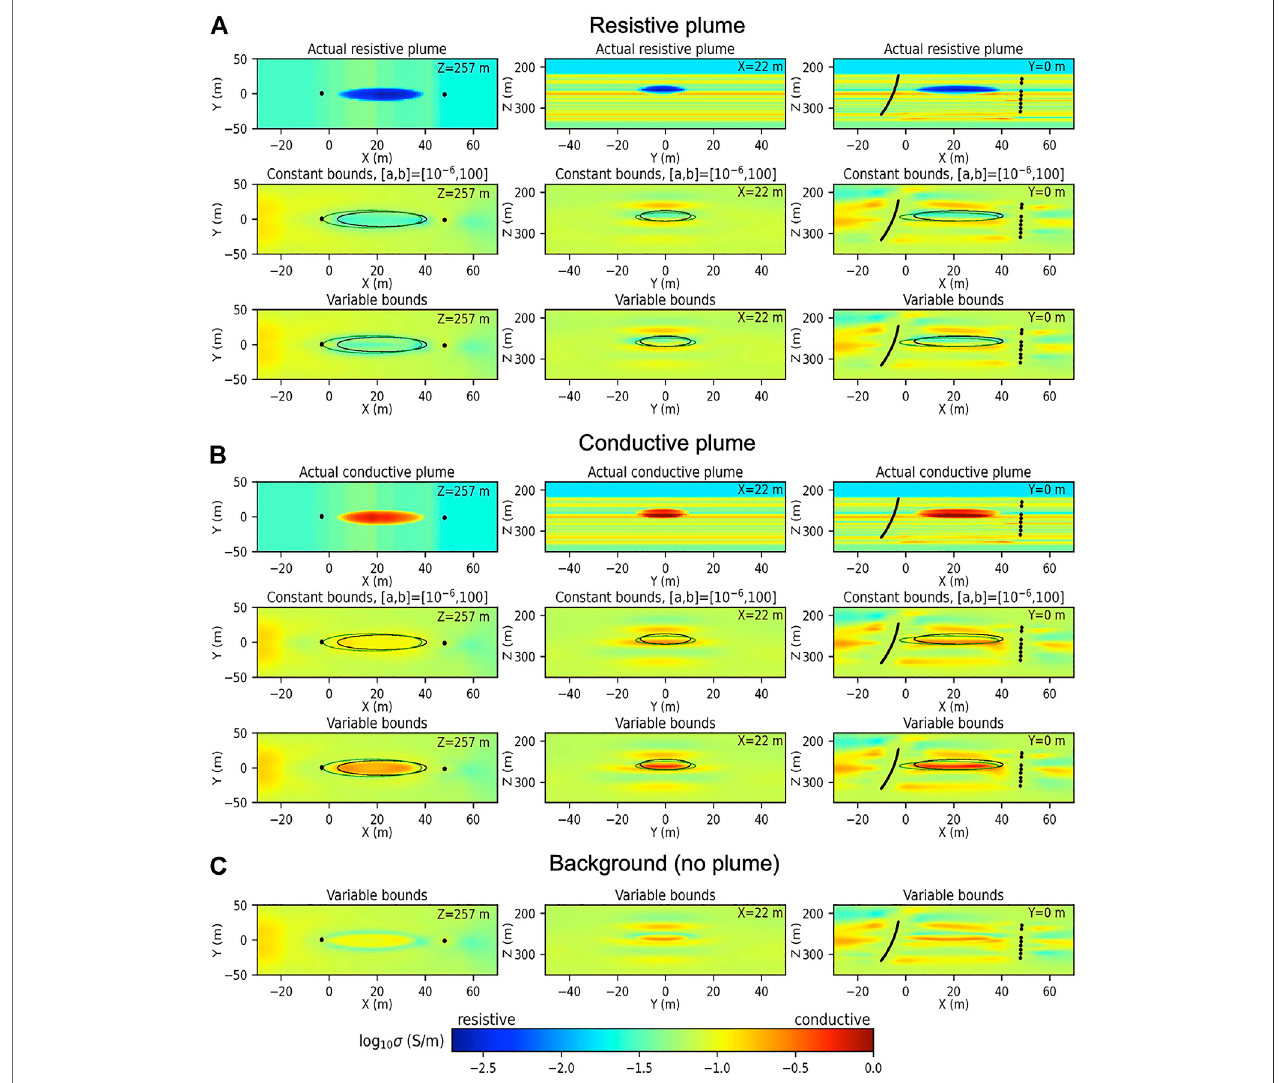
FIGURE 5 | (A) : Plume imaging for CaMI.FRS. Comparative inversions for an electrically resistive plume model. The upper, middle, and lower plot rows show, respectively, true model, inversion result using constant bounds, and inversion result using spatially variable bounds. (B) : Comparative inversions for an electrically conductive plume model. The upper, middle, and lower plot rows show, respectively, true model, inversion result using constant bounds, and inversion result using spatially variable bounds. The corresponding variable lower and upper parameter bounds are shown by Figure 4 . Elliptical contour lines in the images outline true (black) and assumed (green) plume boundaries. Assumed boundaries pertain to the ellipsoidal region de fi ning the variable lower and upper parameter bounds. (C) : Inversion of data set created from the background model using the variable bounds.